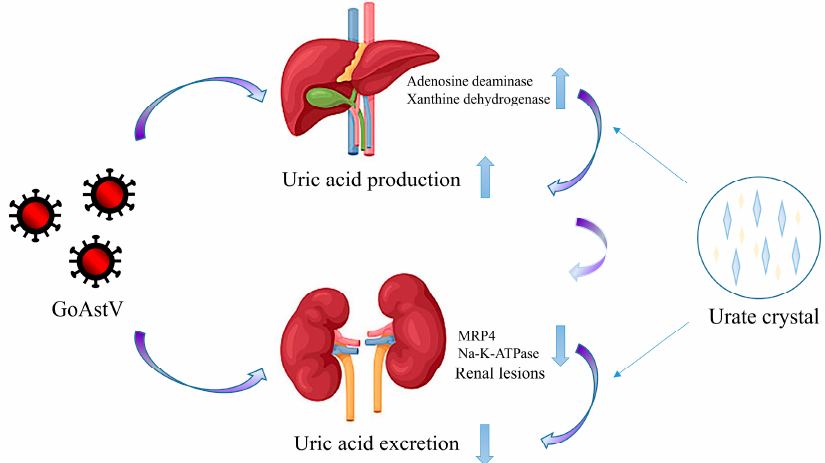
Figure 6. Pathogenesis of liver and kidney in gosling gout induced by GoAstV.